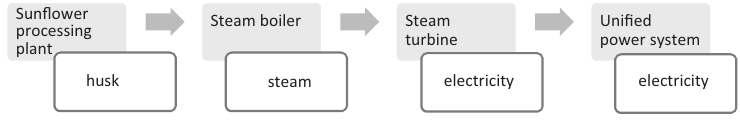
Figure 2. Scheme of electricity production from sunflower husk (source: based on Hrytsyuk, 2008)